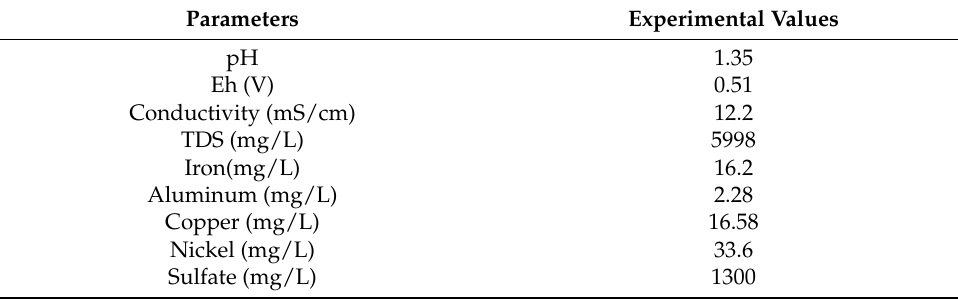
Table 2. Characteristics of raw synthetic